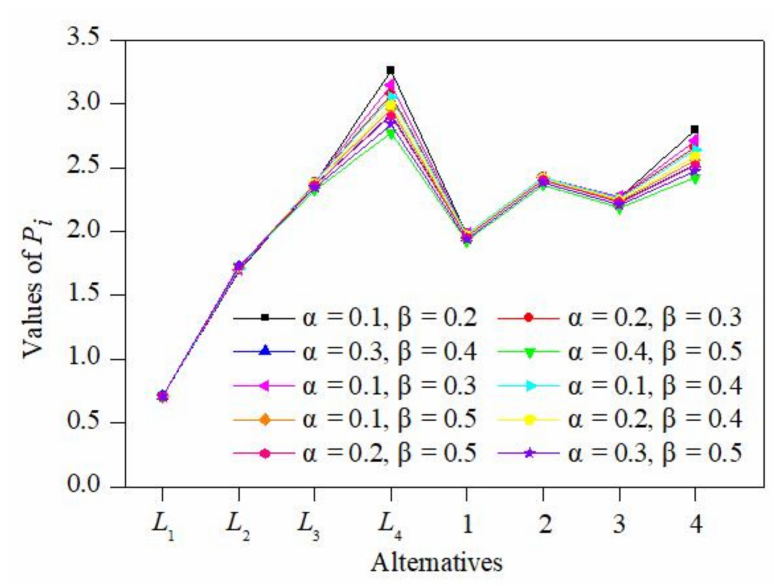
Figure 4. Values of P i under different circumstances. Table 14. Evaluation results under different values of α and β for each